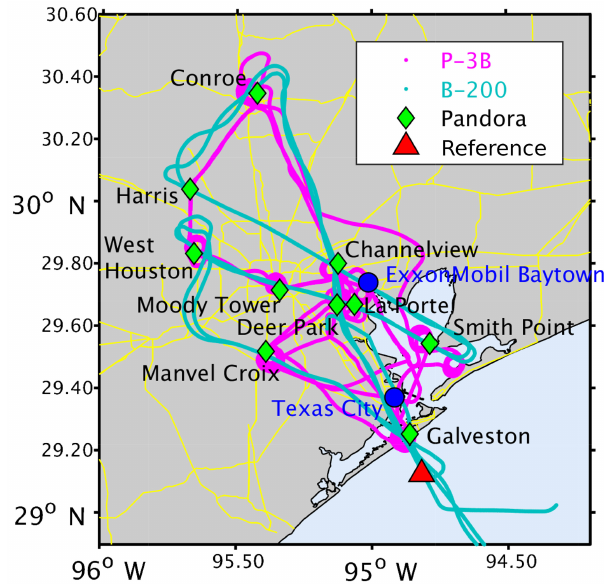
Figure 1. Map of Houston area showing sample flight tracks for the King Air B-200 (GCAS) and the P-3B aircraft on 6 September 2013, and ground sites where Pandora spectrometers were located. Major roads are shown in yellow. ExxonMobil Baytown and Texas City are large petrochemical and petroleum refinery complexes. The Baytown complex lies near the entrance to the main part of the Houston Ship Channel industrial area, which ends 6.5km to the east of the downtown. The red triangle shows the location of the observations used to calculate the GCAS reference spectra.